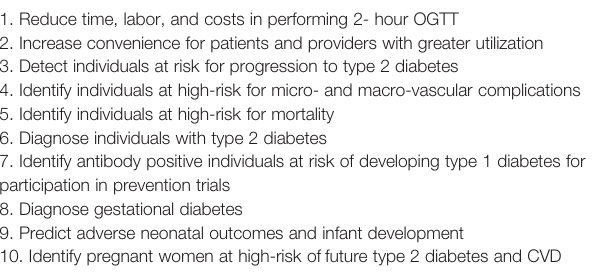
TABLE 1 | Potential roles for the 1-hour plasma